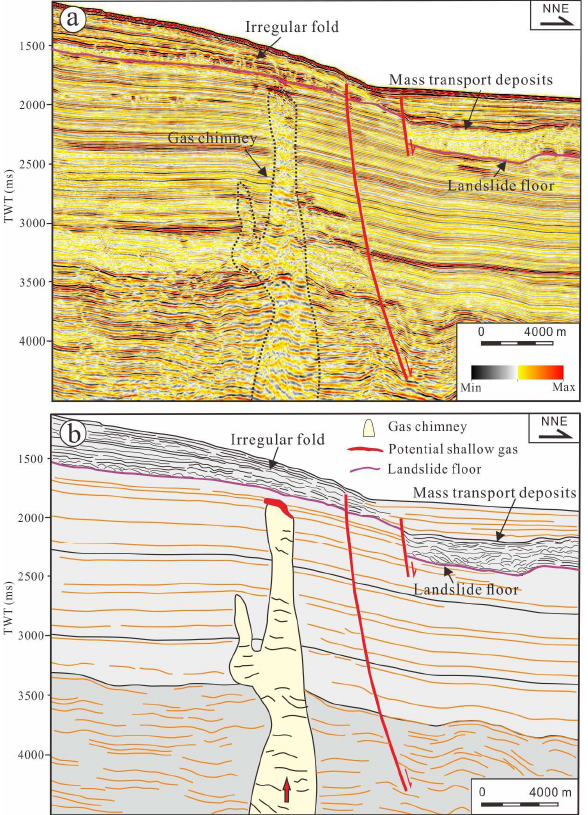
Figure 6. Seismic profile ( a ) and geological interpretation ( b ) showing the mass transport deposits with gas chimneys on the middle- and lower-continental shelf slopes of the southern South China Sea. Faults rarely develop in this area and the strata spread more gently. Potential shallow gas accumulates at the top of the gas chimney. The location of Figure 6 correspond to the red line E in Figure 1.